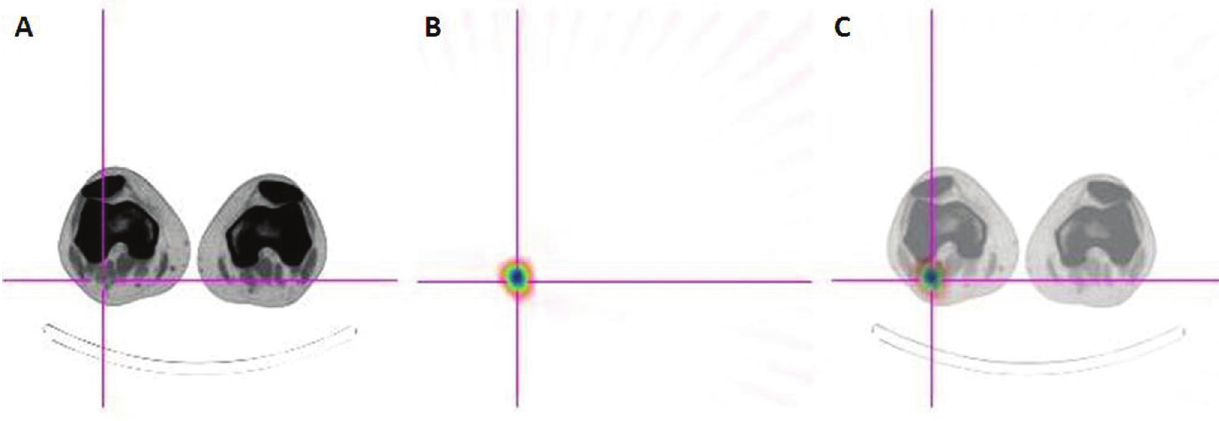
Figure 4 - SPECT-CT performed after Sn- 99m Tc injection in the lesion of the right popliteal fossa. A) Anatomical image. B) Metabolic image. C) Fusion of the two methods